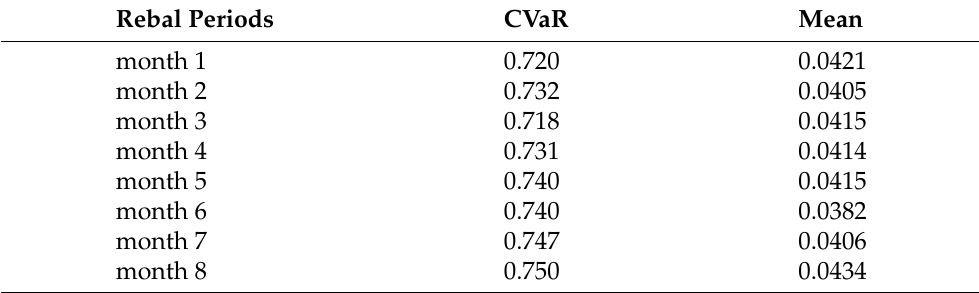
Table 12. CVine: CVaR and